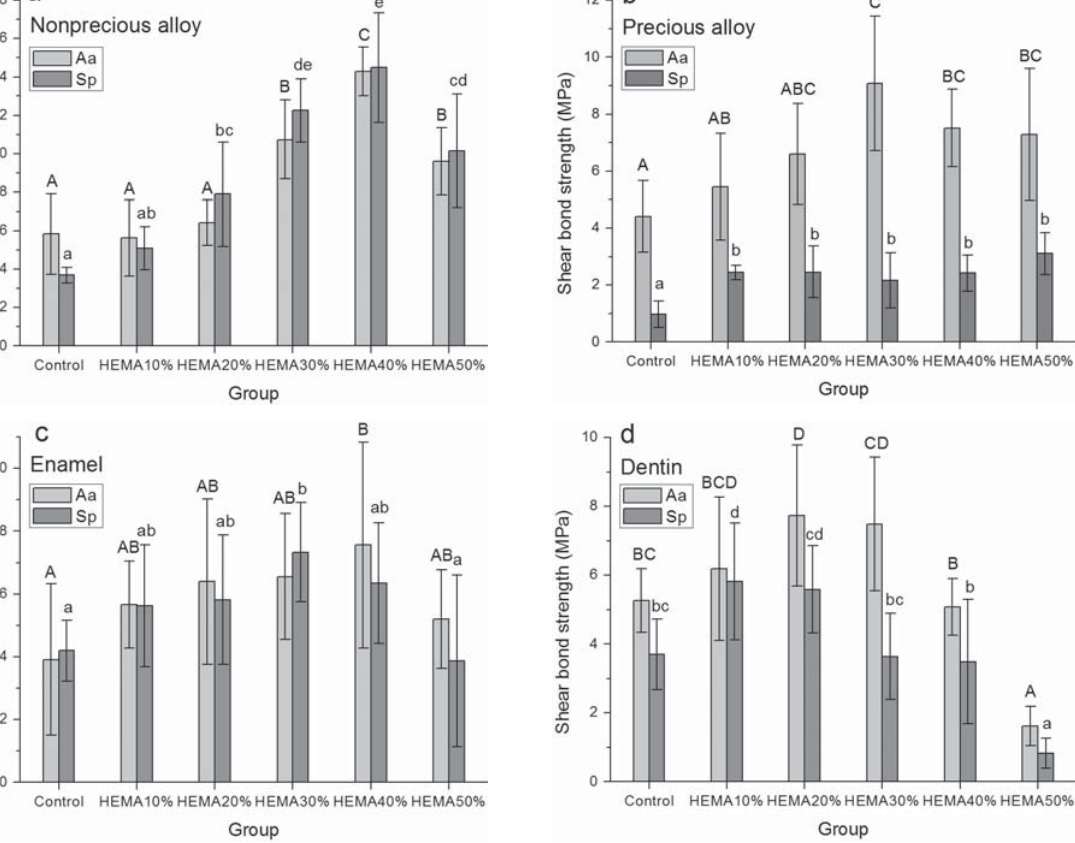
FIGURE 2- Shear bond strength of experimental HEMA-added glass ionomer cement to a nonprecious alloy (a), a precious alloy (b), enamel (c), and dentin (d). Aa groups marked with the same uppercase letters were not significantly different (p>0.05). Sp groups marked with the same lowercase letters were not significantly different